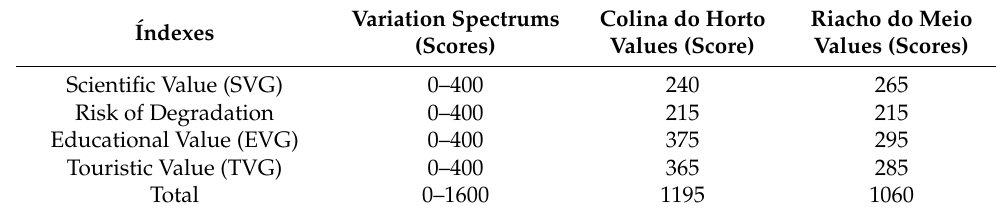
Table 1. Geodiversity indices of Colina do Horto and Riacho do Meio—Araripe UNESCO Global Geoparks Program